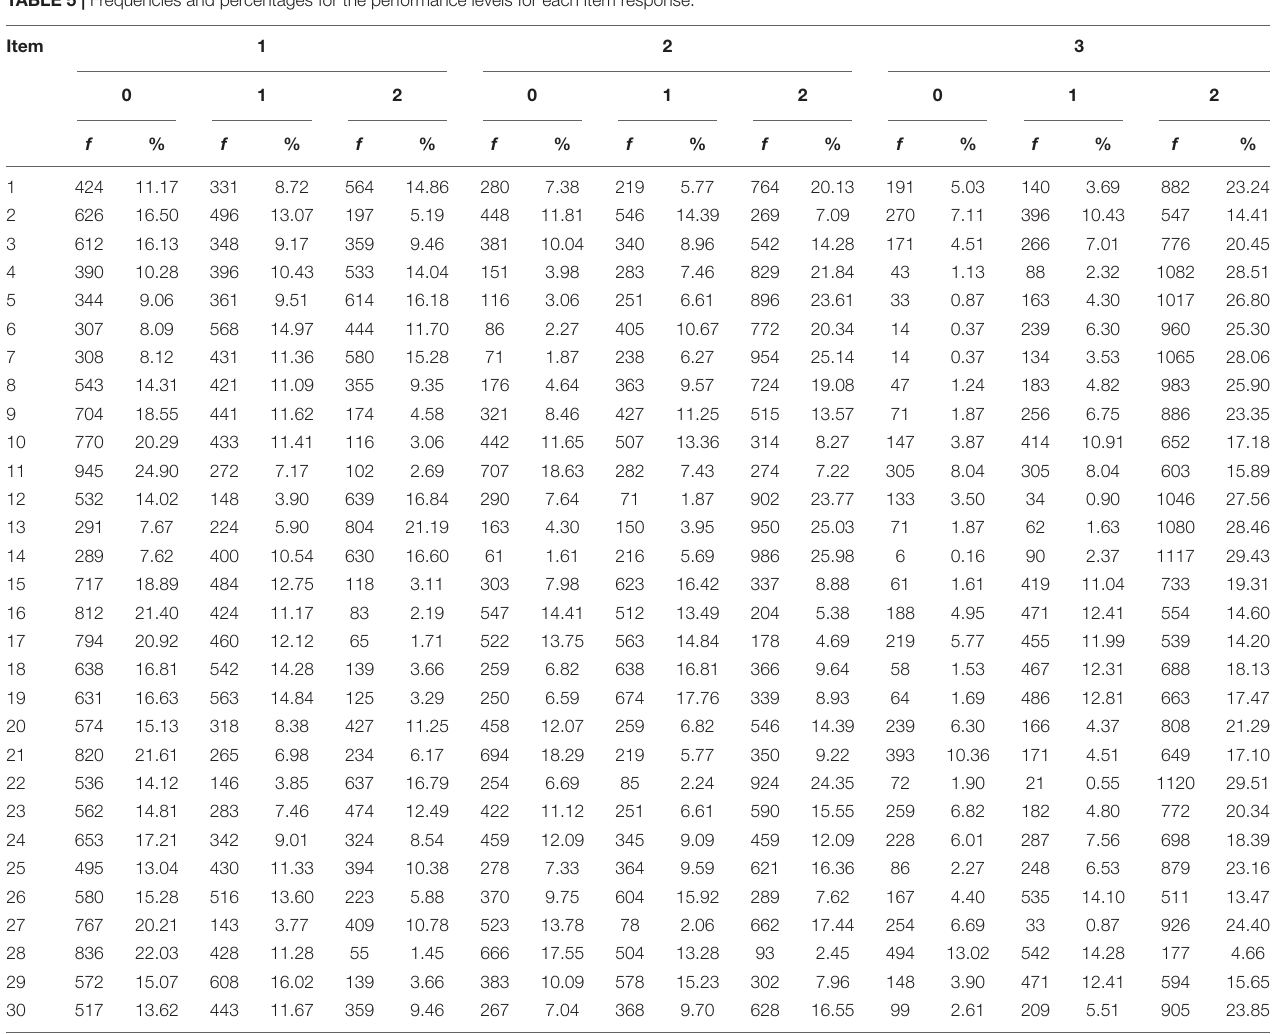
TABLE 5 | Frequencies and percentages for the performance levels for each item